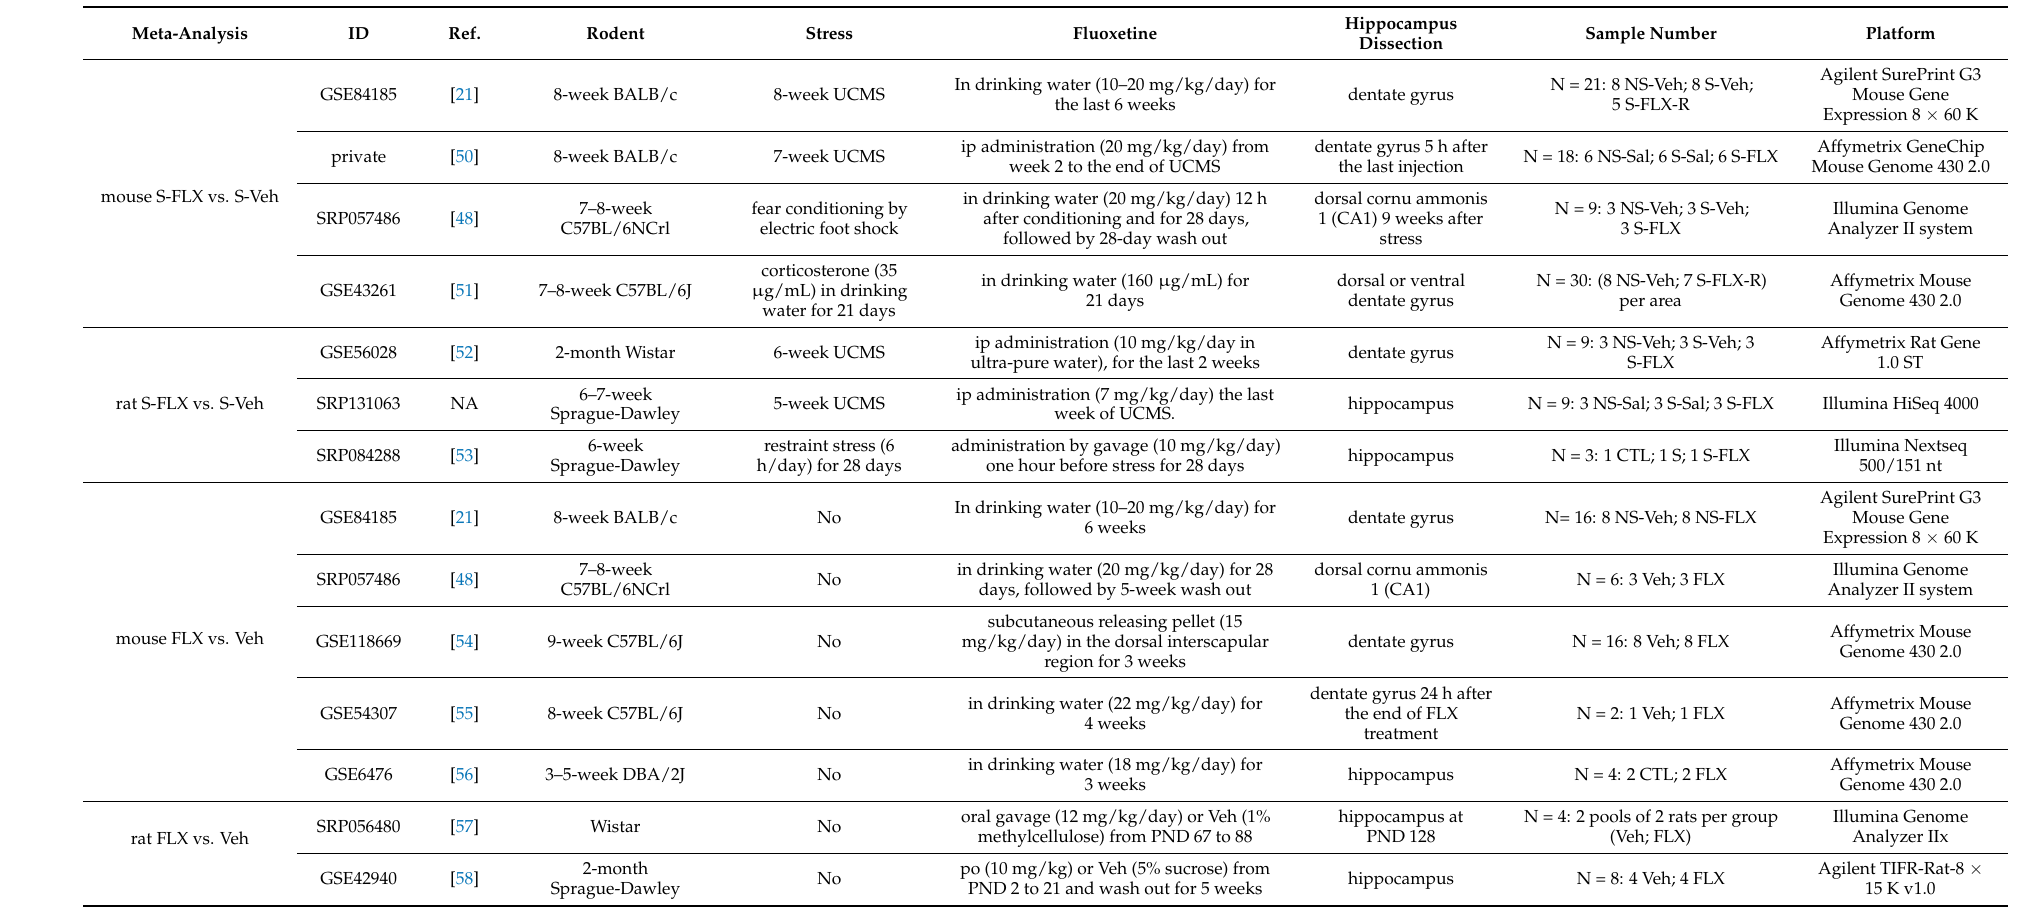
Table 1. Studies selected for